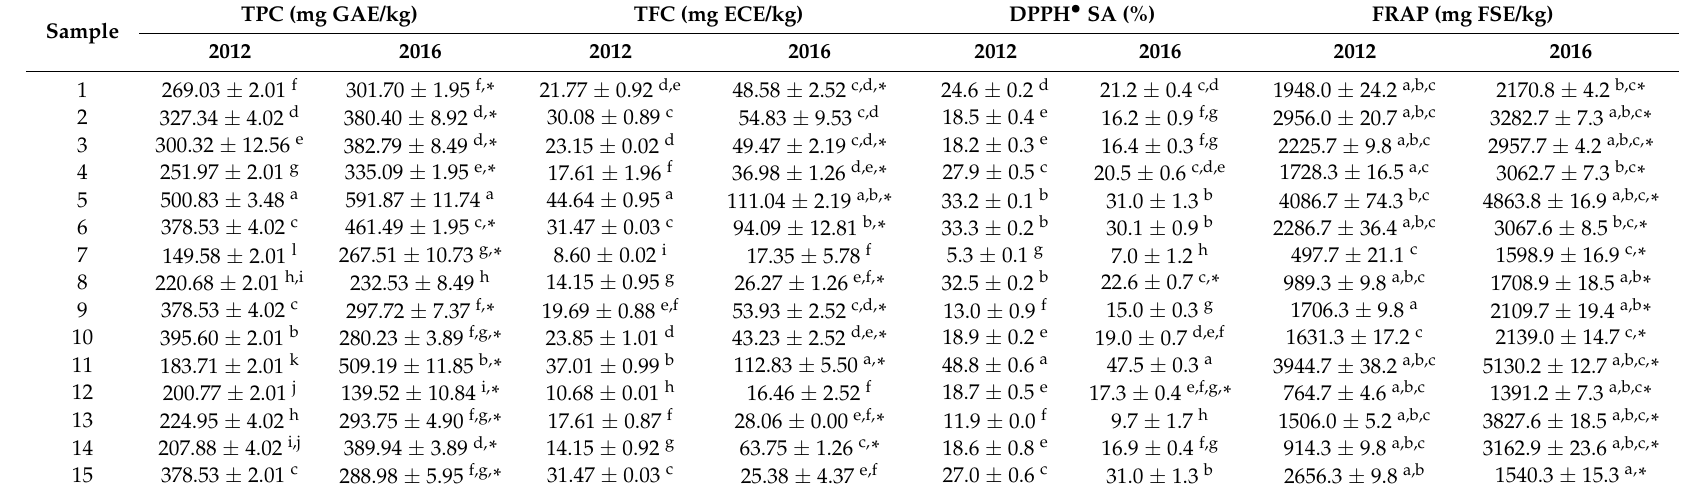
Table 3. Descriptive statistics of storage effect on antioxidant activity and related compounds of the honeys